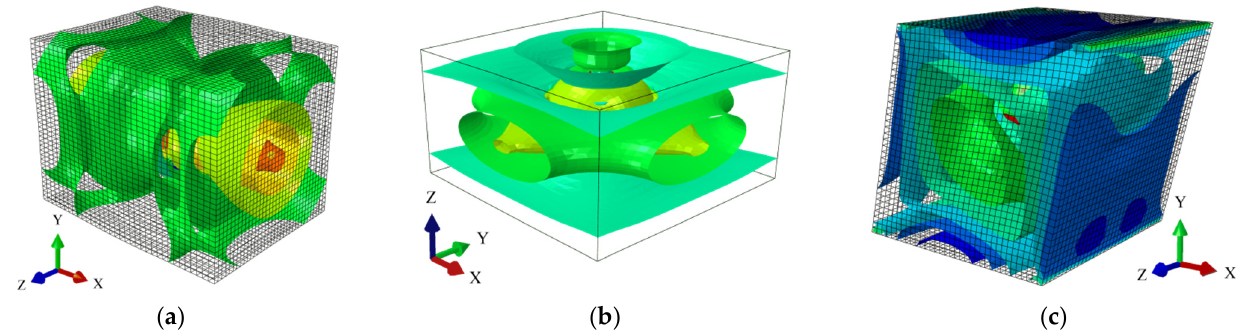
Figure 2. Principal strain isosurfaces for the ( a ) uniaxial and ( b ) biaxial tension, as well as ( c ) shear of the RVE.